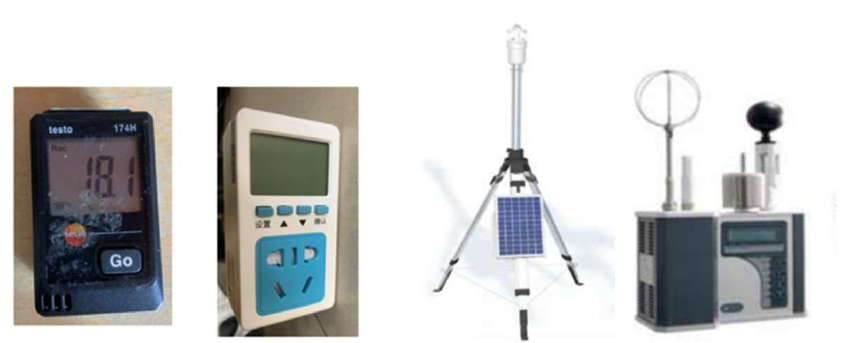
Figure 8. Some of the appliances